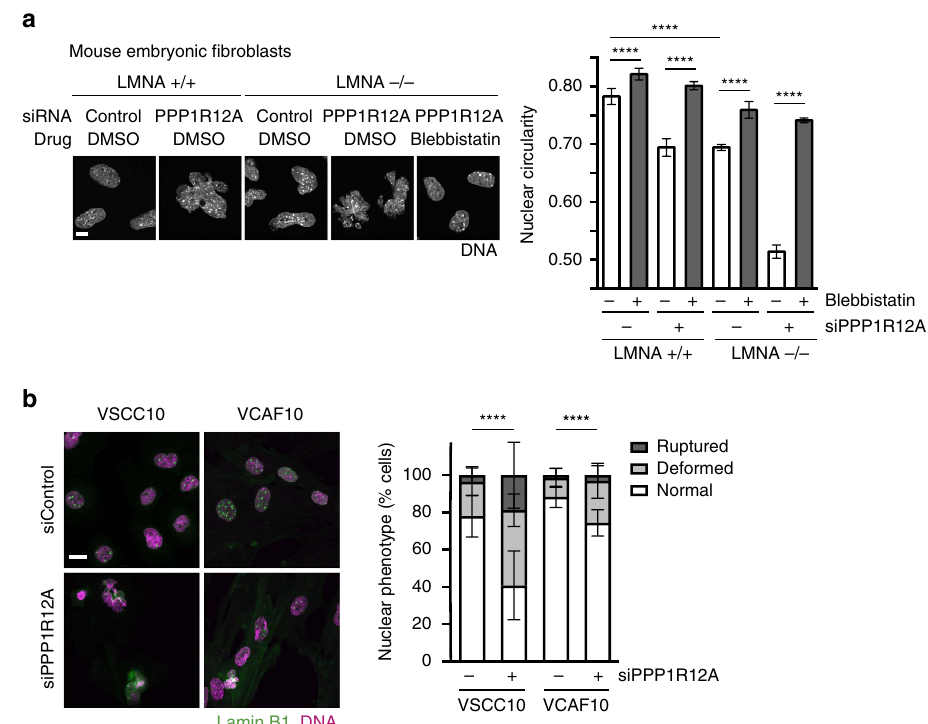
Figure 4 | Impact of PPP1R12A depletion on nuclear morphology in LMNA (cid:2) / (cid:2) and patient-derived cells. ( a ) LMNA þ / þ and (cid:2) / (cid:2) mouse embryonic fibroblasts were transfected with the indicated siRNA duplexes and stained with DAPI 56h after transfection. Cells were exposed to DMSO solvent control or 5 m M blebbistatin for 24h before fixation. Representative images (left panel) and quantification of nuclear circularity (right panel) are shown. Error bars, s.d. of three independent experiments ( n 4 100 nuclei each). Scale bar, 10 m m. ( b ) Vulval squamous cell carcinoma cells (VSCC10) and vulval cancer-associated fibroblasts (VCAF10) primary cells were transfected with the indicated siRNAs for 48h. Representative cell images (left panel) and quantification of nuclear phenotype (right panel) are shown (VSCC10 siControl; n ¼ 100, siPPP1R12A; n ¼ 82, VCAF10 siControl; n ¼ 89, siPPP1R12A; n ¼ 78 cells per condition). Scale bar, 20 m m. Graphs show **** P o 0.0001 ( a unpaired t test; b w 2